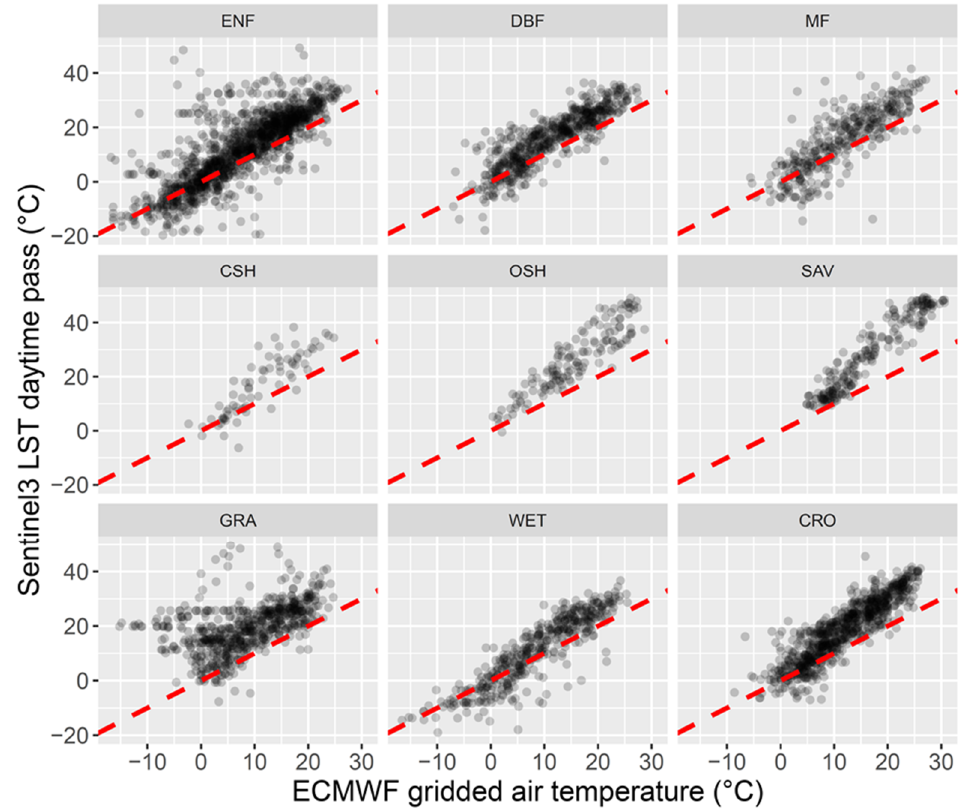
Figure 1. Scatterplots comparing ECMWF gridded air temperatures with Sentinel3 daytime LST estimates; organised by vegetation class: evergreen needleleaf forest (ENF), deciduous broadleaf forest (DBF), mixed forest (MF), closed shrublands (CSH), open shrublands (OSH), savannahs (SAV), grasslands (GRA), permanent wetlands (WET) and croplands (CRO). The dashed red line shows the ideal fit. Each point is a ten-day average.